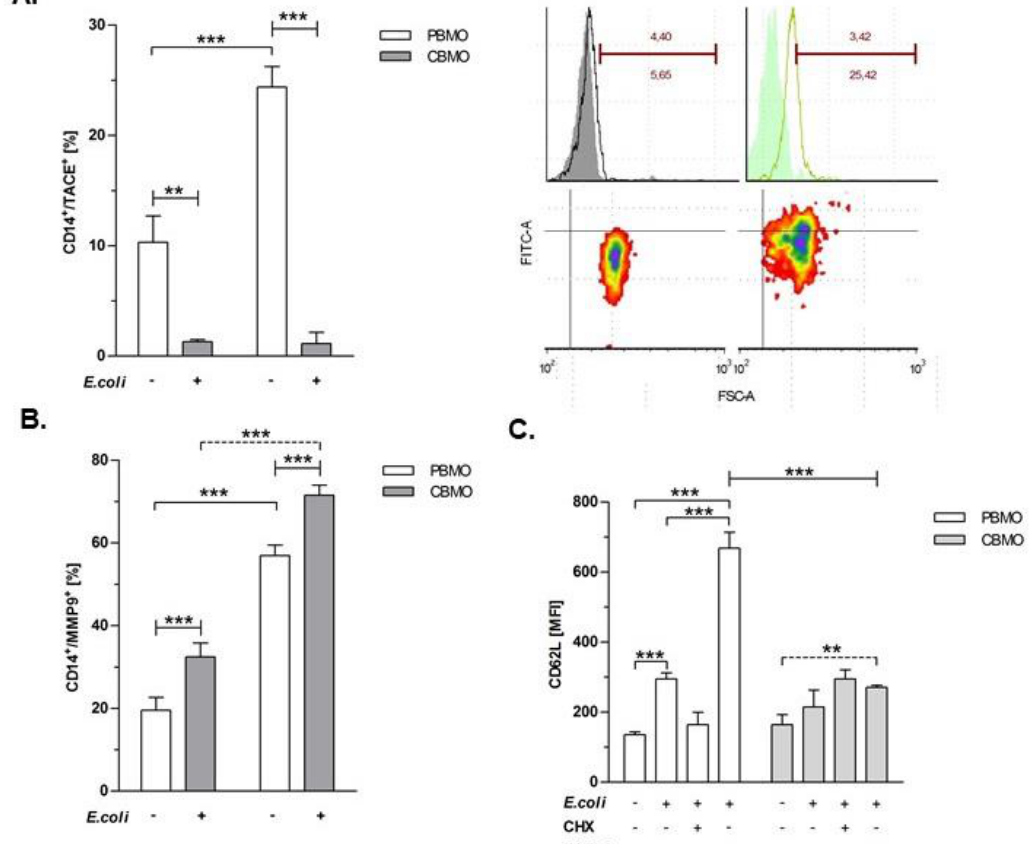
Figure 1. TACE and MMP-9 expression is induced four hours p.i. by infection with E. coli . TACE expressing monocytes were assessed before and after infection with E. coli . ( A ) Histogram plots to the right compare isotype controls (filled) and anti-TACE stained PBMO which were non-infected or E. coli infected. Density plots (below) detail the distribution of E. coli infected PBMO regarding TACE surface expression (compare to the non-infected PBMO to the left). E. coli MMP-9 expressing monocytes were assessed before and after infection with E. coli . ( B ) ( n = 5, *** p < 0.001, forked bars represent Student’s t -test, blunt-ended bars represent ANOVA). Blocking of TACE activity increases its substrate CD62L. ( C ) Monocytes were infected with GFP- E. coli for 4 h with or without indicated inhibitors and surface expression of CD62L was determined. ( A – C ); ( n = 5, ** p < 0.01, *** p < 0.001, forked bars represent Student’s t -test, blunt-ended bars represent